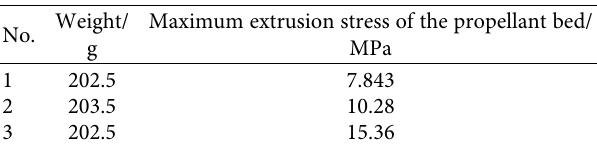
Table 4: Fragmentation test data of propellant samples aged for 30